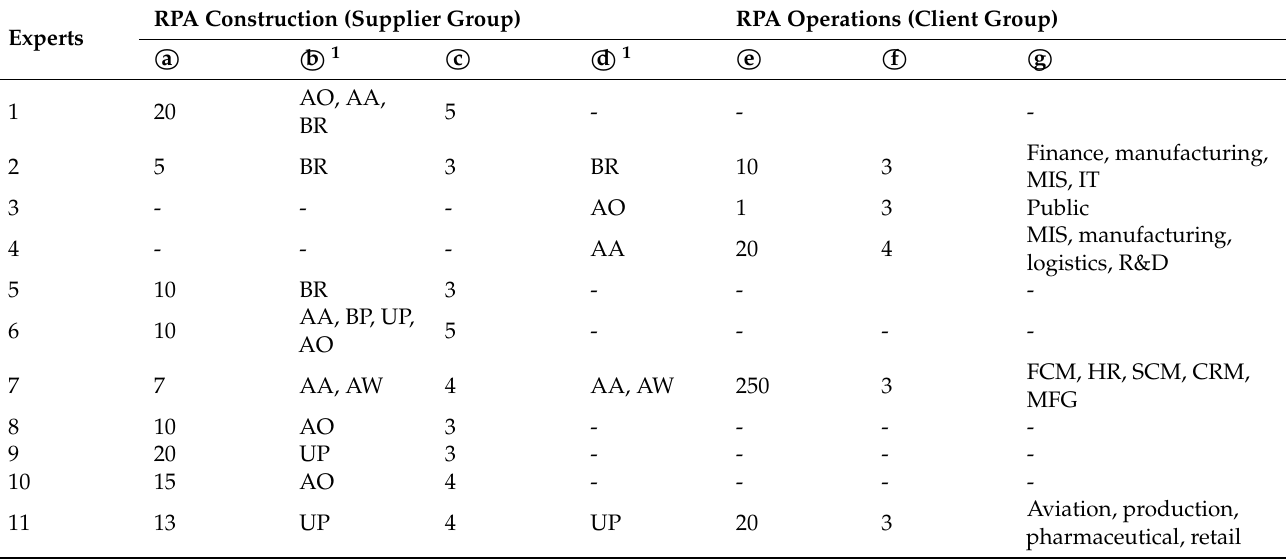
Table 5. Information regarding experts who participated in this